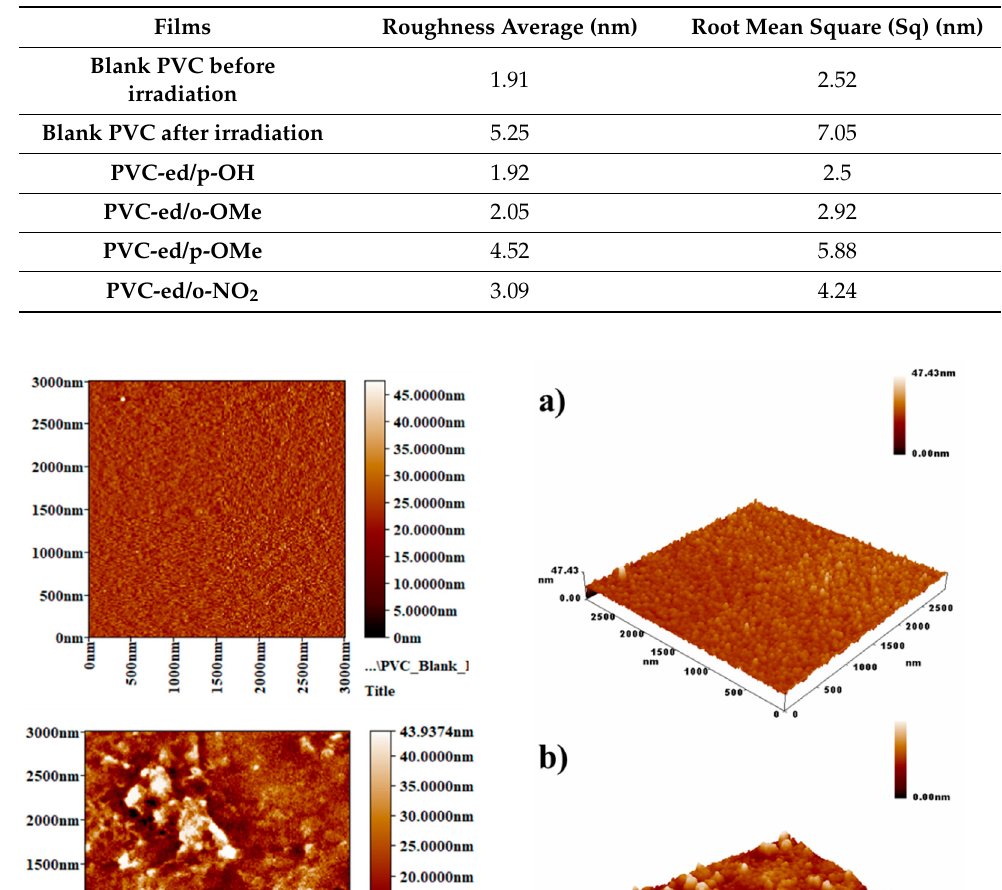
Table 2. Roughness data for blank and blended PVC films.